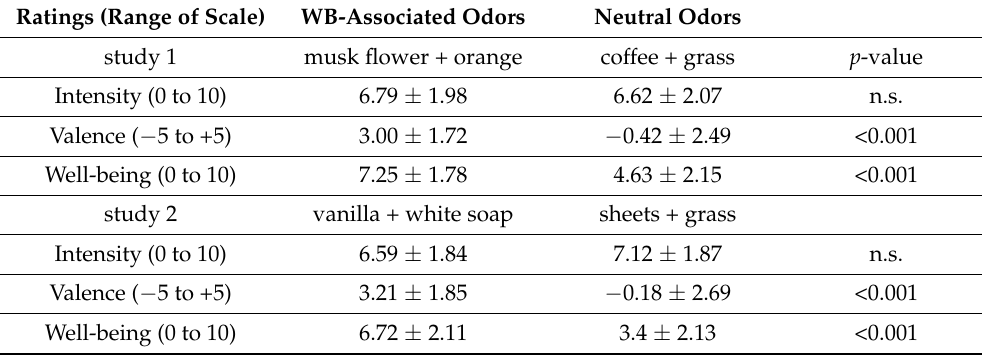
Table 1. Odor ratings in studies 1 and 2. Data are represented as means ± standard deviations; n.s. =